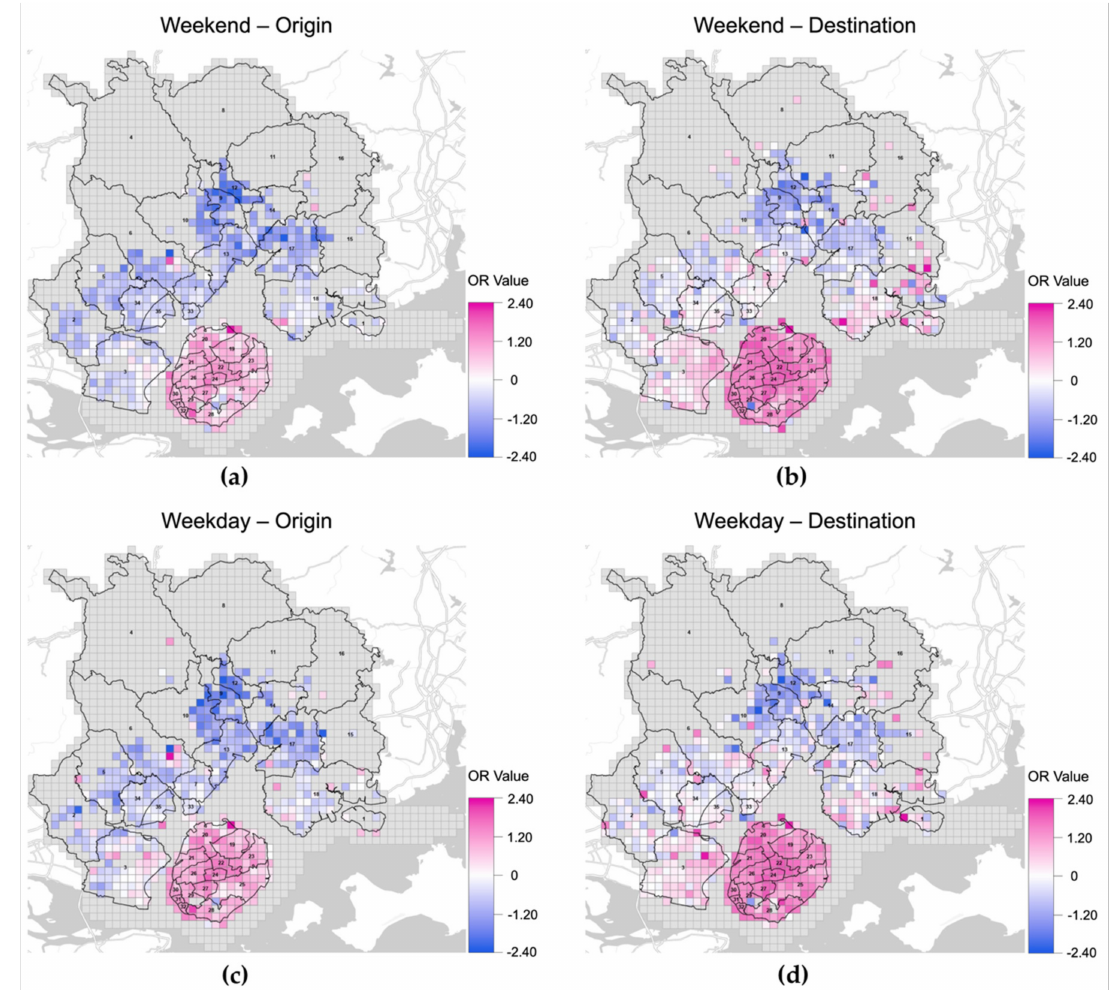
Figure 9. Odds ratio (OR) distributions for each day-trip